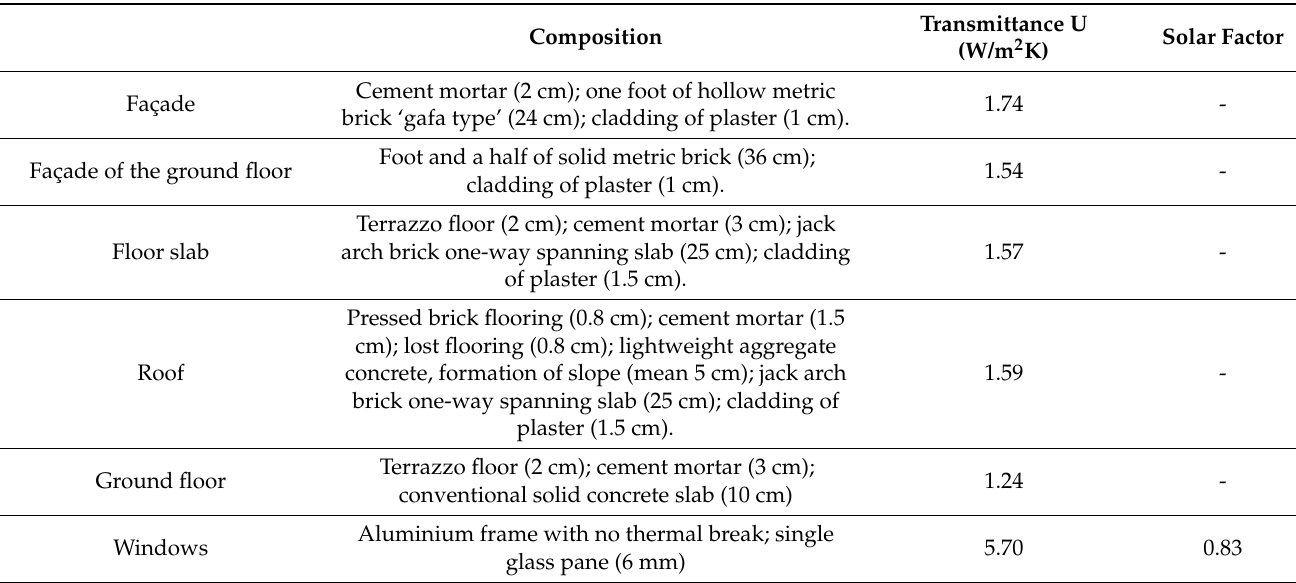
Table 2. Constructive building